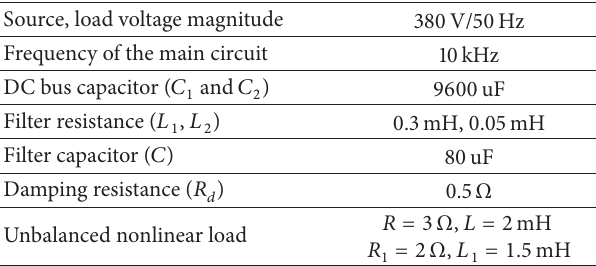
Table 2: Simulation parameters.